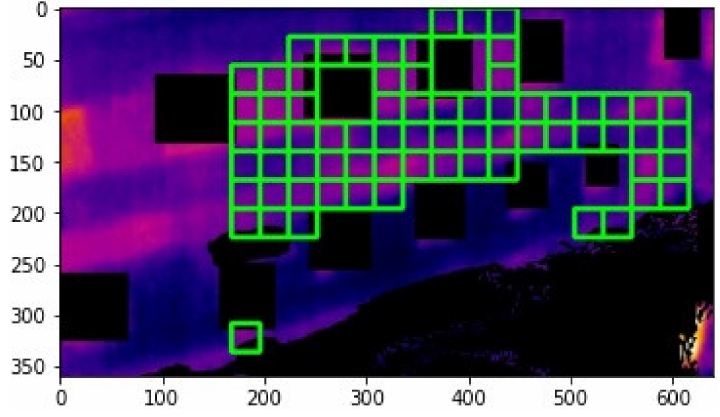
Figure 7. Detected areas with possible insulation